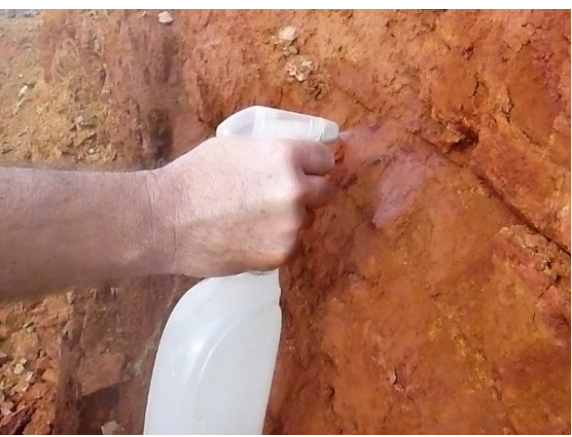
Figure 6. Water saturation in the